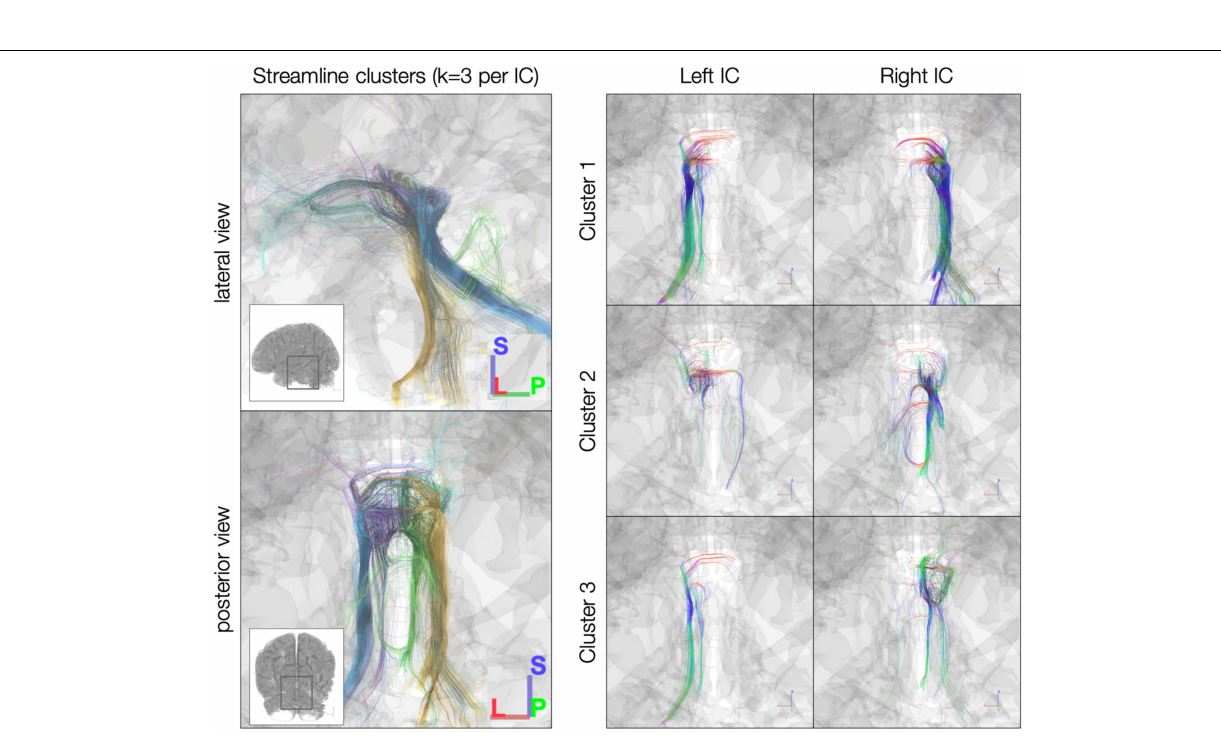
Frontiers in Neuroscience |